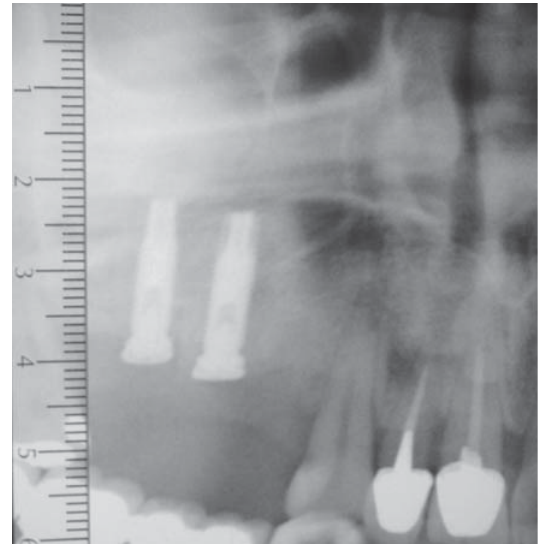
FIGURE 1- Two implants inserted in the upper right maxilla